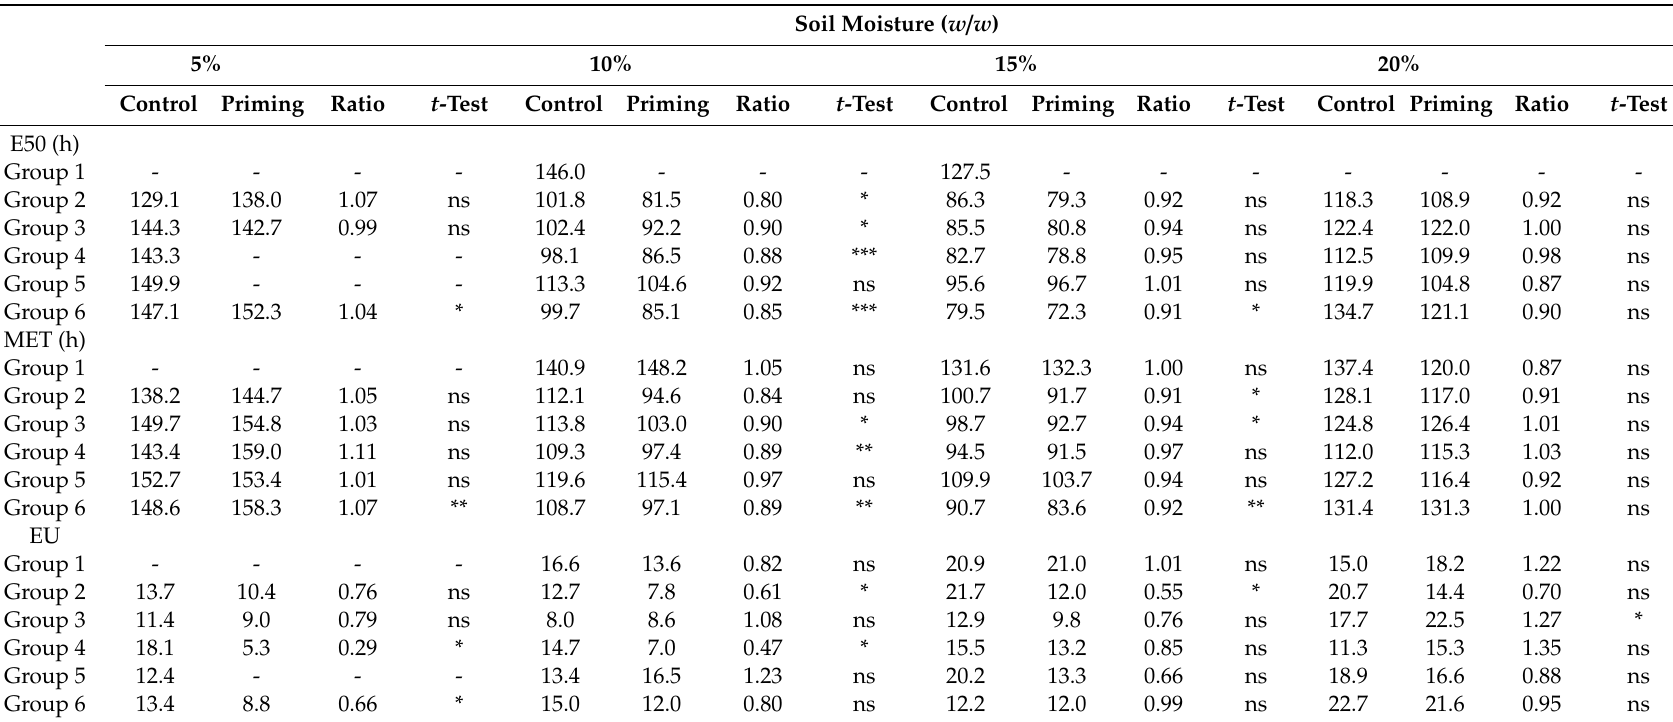
Table 3. E ff ects of priming on time to achieve 50% plant emergence (E50), mean plant emergence time (MET), and plant emergence uniformity (EU) of six genotypic groups under four soil moisture